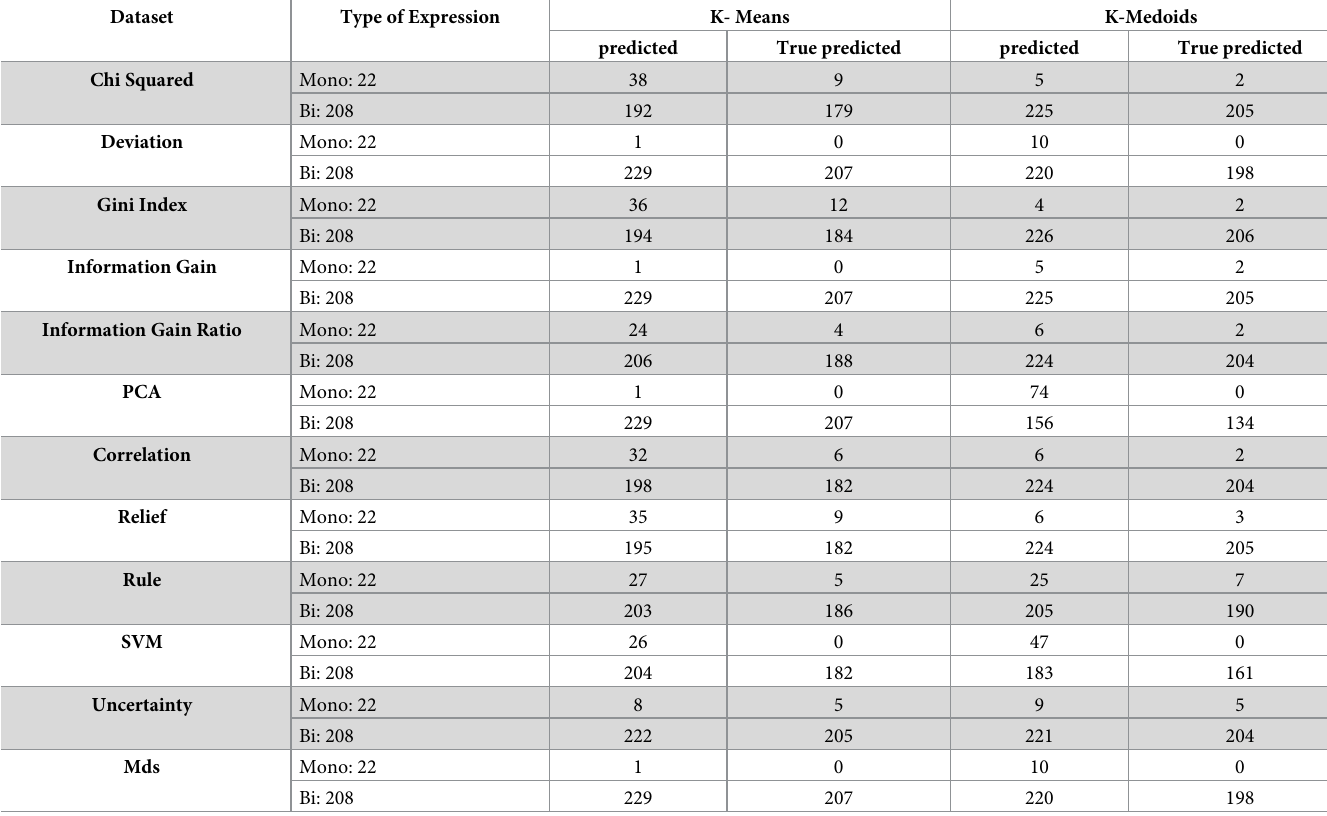
Table 5. Clustering of 12 datasets (Mds and Awds) into MONO and BI classes by different unsupervised clustering algorithms (K-Means and K-Medoids).